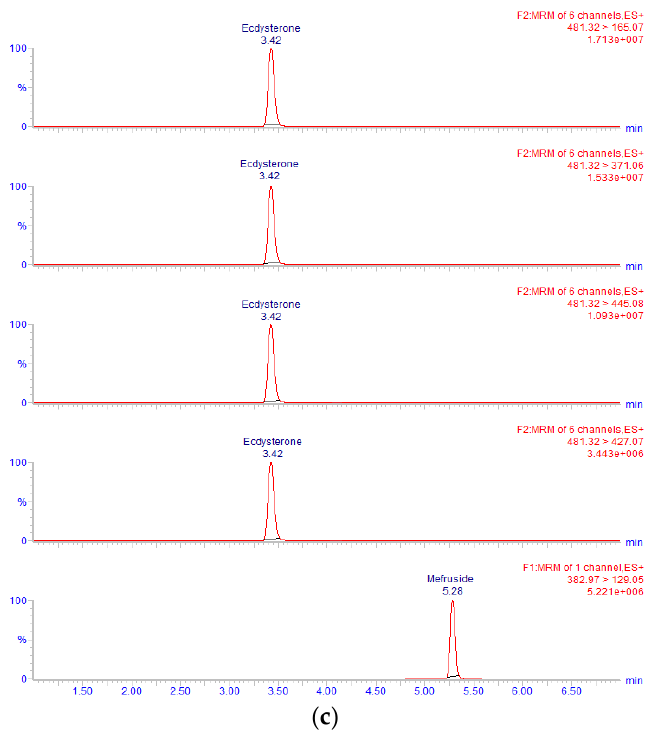
Figure 2. Chromatograms from the analysis of a sample dietary supplement ( a ) blank sample; ( b ) investigated sample (estimated concentration 383 mg/g); ( c ) QC sample (at 250 mg/g) .